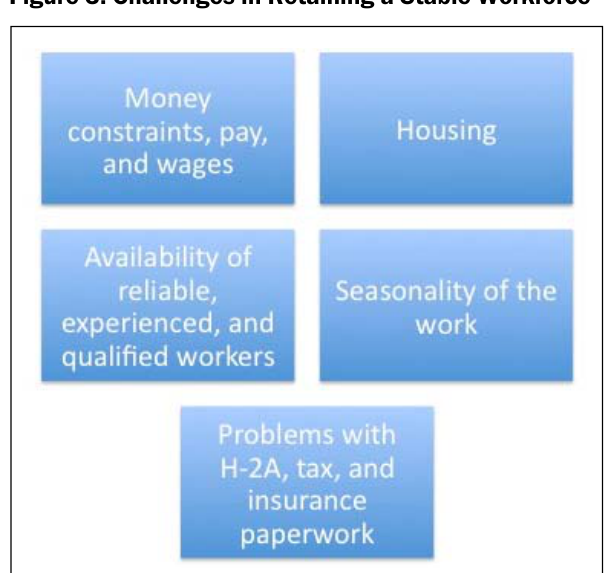
Figure 3. Challenges in Retaining a Stable